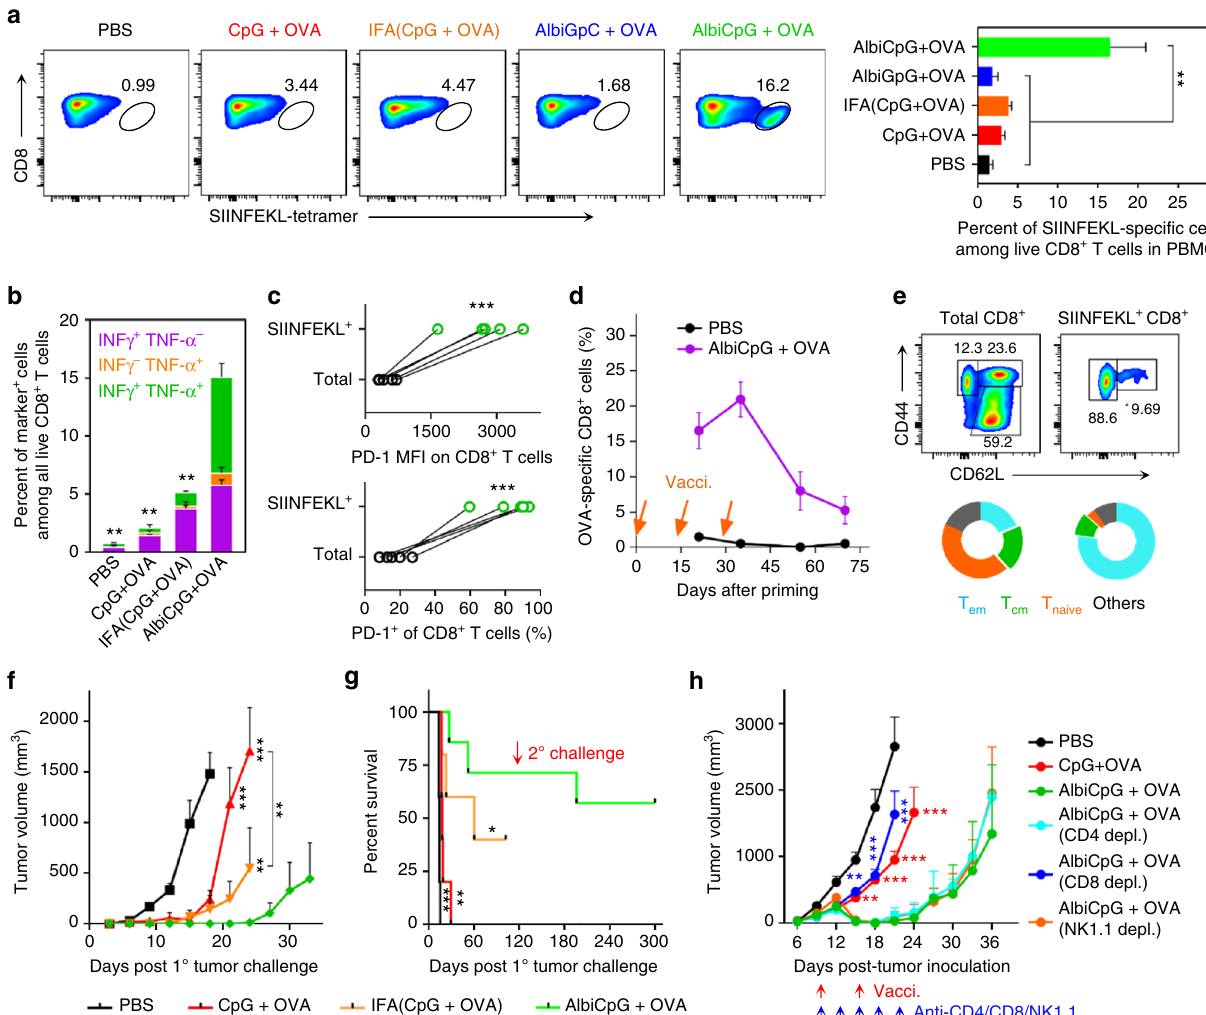
Fig. 4 Albumin/AlbiVax nanocomplexes induced potent and durable antitumor T cell responses. a – g C57BL/6 mice ( n = 5 – 7) were s.c. vaccinated with AlbiVax (2 nmol AlbiCpG equivalents + 10 µ g OVA) at the tail base on day 0, day 14, and day 28, followed by immune analysis on day 21, day 35, and day 70, and 1° tumor challenge on day 71. a Representative fl ow cytometry plots (left) and frequency (right) of SIINFEKL + CD8 + T cells in peripheral blood on day 21 stained using phycoerythrin (PE)-labeled H-2K b -SIINFEKL tetramer. b Percentage of cytokine-producing CD8 + T cells in peripheral blood, measured by intracellular staining of IFN- γ and TNF- α on day 21. c Higher level (MFI) and frequency of PD-1 expression on SIINFEKL + CD8 T cells than that on total CD8 + T cells in peripheral blood on day 21. (Two-tailed paired t test.) d Frequencies of SIINFEKL + CD8 + CTLs in peripheral blood over 70 days post priming. e Representative fl ow cytometry results (upper) and percentage (lower) of effector memory T cells (Tem, CD62L − CD44 + ), central memory T cells (Tcm, CD62L high CD44 + ), and naive T cells (CD62L + CD44 − ) in peripheral blood on day 70, showing AlbiVax-induced T cell memory. f , g Tumor growth curve ( f ) and mouse survival ( g ) after s.c. challenging vaccinated mice with EG7.OVA cells. 1° challenge: 3 × 10 5 cells on the right shoulder on day 71 post priming vaccination; 2° challenge: 1 × 10 6 cells on the right fl ank on day 211. h AlbiCpG + OVA regressed established EG7.OVA tumor. C57BL/6 mice ( n = 6 – 8) were s.c. inoculated with 3 × 10 5 EG7.OVA cells on day 0, and treated with AlbiCpG + OVA (2 nmol CpG equivalents, 20 µ g OVA) on day 6, day 12, and day 18. Lymphocyte depletion by anti-CD8, but not anti-CD4 or anti-NK1.1 (200 μ g, on day 6, day 9, day 12, day 15, and day 18) abrogated the therapeutic ef fi cacy of AlbiVax. *** p < 0.001, ** p < 0.01, * p < 0.05, ns: not signi fi cant ( p > 0.05), by one-way ANOVA with Bonferroni post test, unless denoted otherwise. Data show mean ± s.e.m. of two – three independent experiments. Asterisks in a , b , f – h indicate statistically signi fi cant differences between